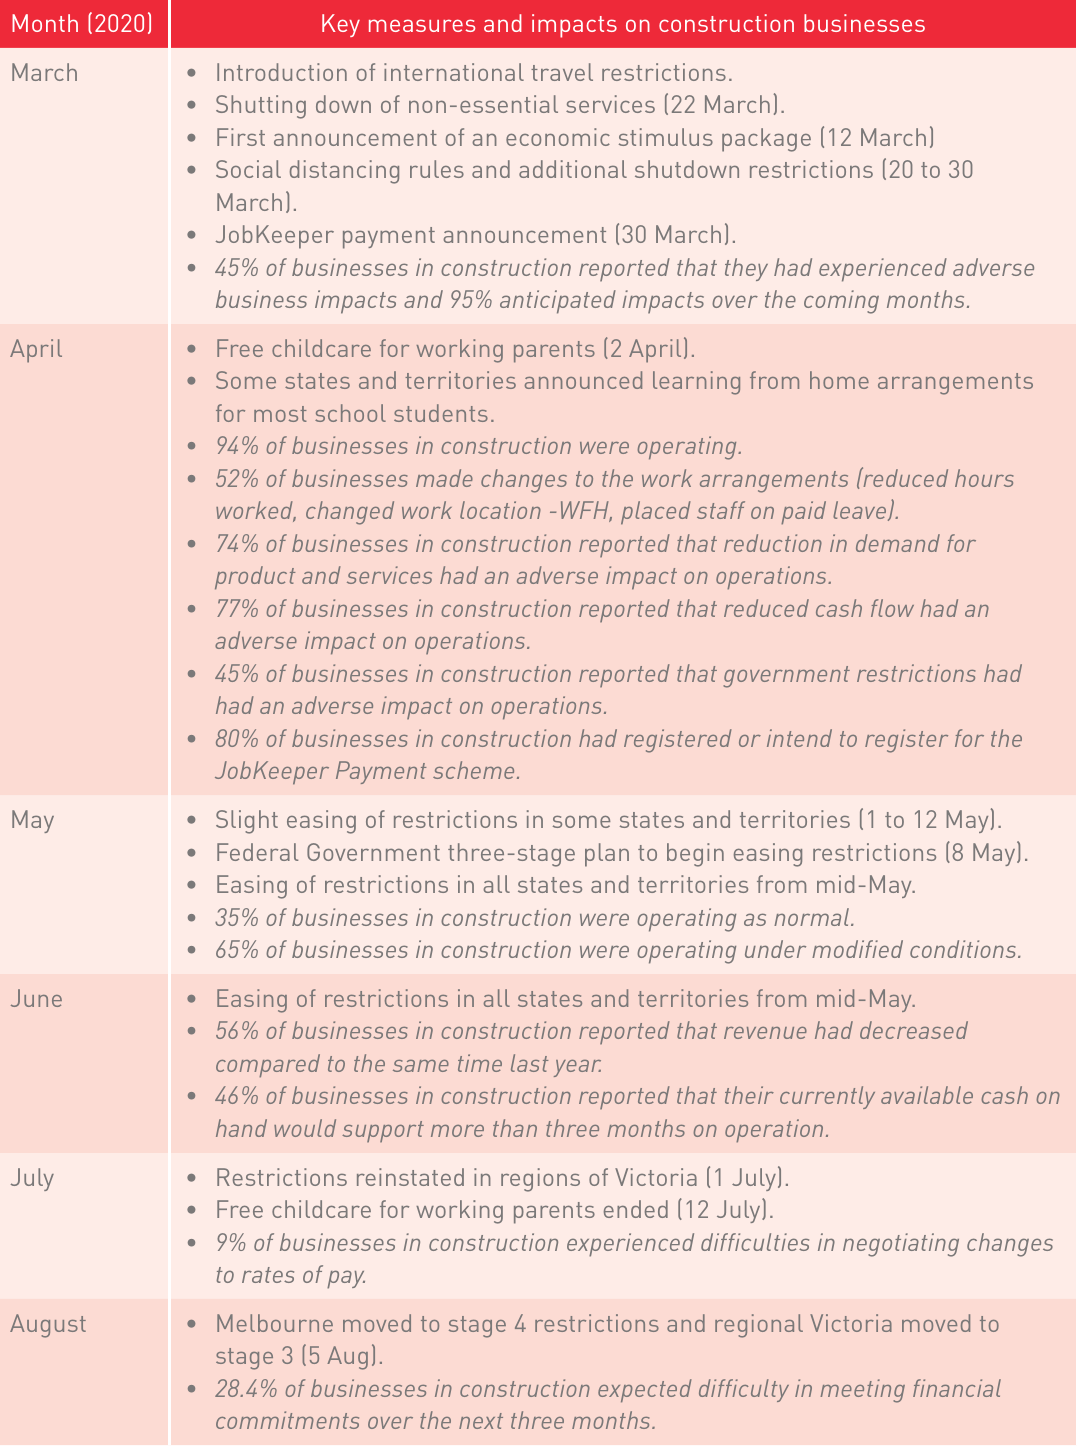
Table 1. The Australian government measures in response to COVID-19 pandemic and its impacts on construction